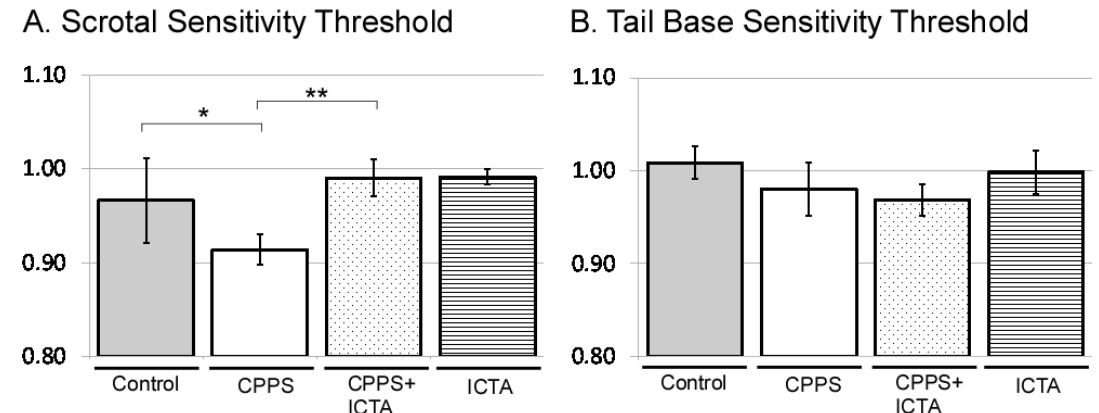
Figure 2. Inflammatory cytokine-targeting aptamers (ICTA) attenuated local carrageenan-induced hypersensitivity of scrotal wall ( A ) and tail base ( B ) allodynia in the von Frey filament test of Sprague Dawley (SD) rats. ( A ) The CPPS + ICTA group compared with the chronic pelvic pain syndrome (CPPS) group ( n = 6). Local carrageenan treatment resulted in reduction of mean responsive intensity in tail reaction from tactile stimulation in the SD rats. Treatment with ICTA significantly reduced carrageenan-induced pain hypersensitivity in the SD rats. The results are expressed as the mean ± standard error of the mean (SEM) of six animals in each group and were analyzed by one-way analysis of variance (ANOVA). * p < 0.05 represents a significant di ff erence for the CPPS group compared with the sham-operated control group. ** p < 0.05 represents a significant di ff erence for the CPPS + ICTA group compared with the CPPS group ( n =